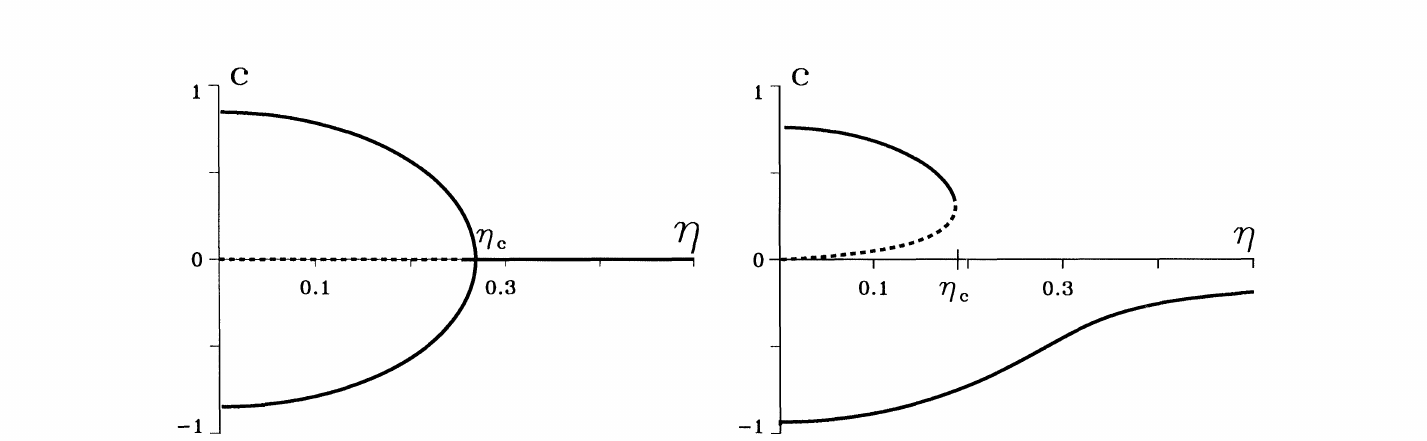
FIGURE 5 Pitchfork front bifurcations showing front solutions of Eq. (5) that propagate at constant velocities, c, as functions of the control parameter / ((b) /. The symmetric bifurcation for a0--0 on the left, and the imperfect bifurcation for a0 --0.1 on the